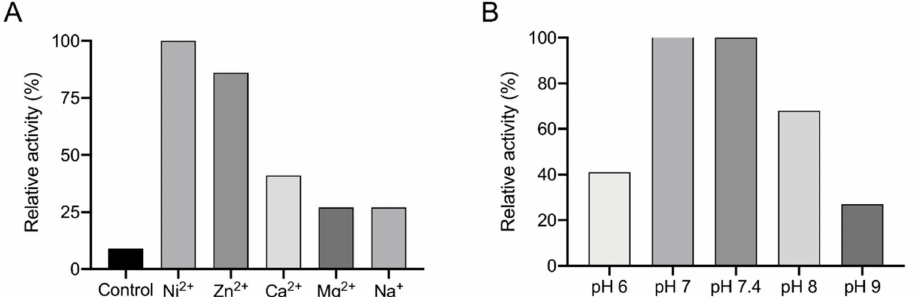
Figure 5. Influence of di ff erent metal ions and pH on the activity of recEhADH3B b . ( A ) After removal of possible metal ions by EDTA (10 mM), the purified recEhADH3B b was dialysed against an EDTA-free bu ff er and incubated for 1 h at 4 ◦ C with di ff erent metal ions (1 mM). Activity was measured using acetaldehyde (20 mM) as substrate as well as NADPH (0.7 mM). As control EDTA-treated and dialysed recEhADH3B b was used. Assays were performed in duplicate. Shown is the relative activity, where the activity of recEhADH3B b in the presence of Ni 2 + was set as 100%. ( B ) Dialyzed recEhADH3B b incubated with Ni 2 + was used to determine the influence of the pH on acetaldehyde dehydrogenase activity. Shown is the relative activity, where the activity of recEhADH3B b in the presence of Ni 2 + was set as